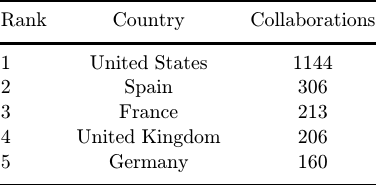
Table 4. Ranking of countries with the greatest collaboration with